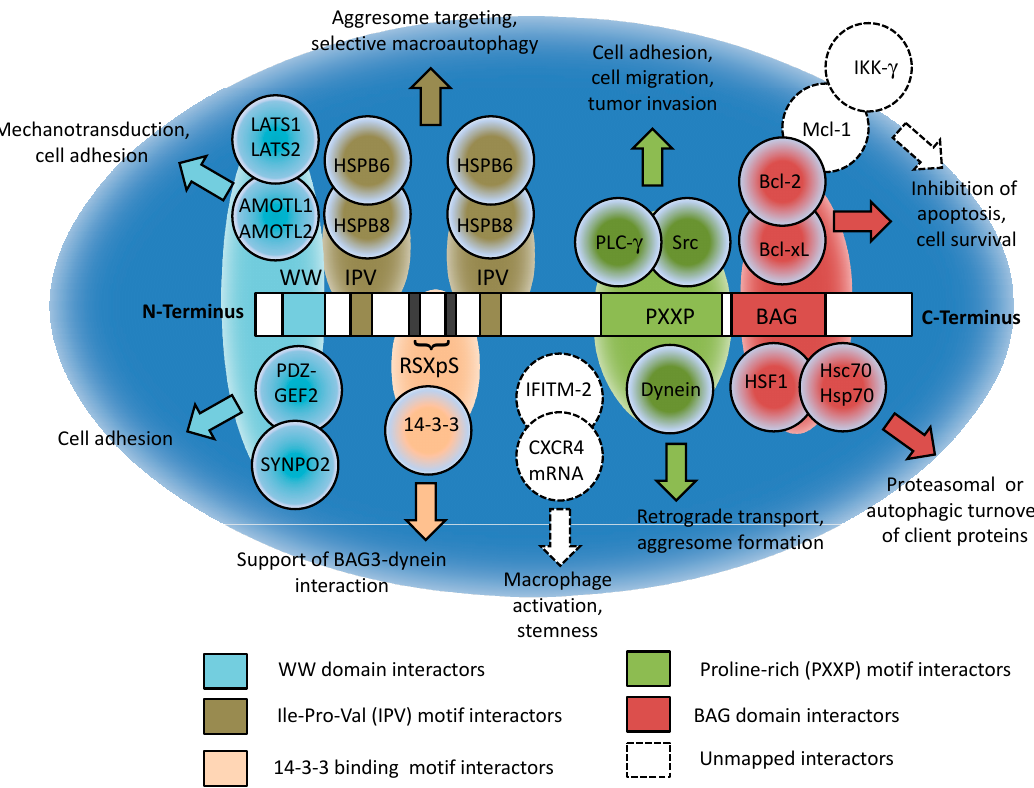
Figure 2. Domain structure of BAG3 and major interactors: BAG3 as a hub molecule regulating multiple pathways related to stress and therapy resistance. Key functional / interaction domains of BAG3, major BAG3 interactors, and associated pathways are depicted. The WW domain of BAG3 binds to proline-rich repeats of interactors, including LATS1 / 2, AMOTL1 / 2, the guanine nucleotide exchange factor 2 (PDZGEF2), and synaptopodin-2 (SYNPO2). The two conserved IPV motifs mediate complex formation of BAG3 to the small heat shock proteins HSPB8 and HSPB6. The PxxP motif interacts with the SH3 (Src homology 3) domains of phospholipase C gamma (PLC- γ ), Src and the motor protein dynein. BAG3 also possesses two phosphoserine-containing 14-3-3 binding motifs that interact with the 14-3-3 γ protein. The C-terminal BAG domain of BAG3 binds to several interactors, including the anti-apoptotic BCL-2 protein, the ATPase domain of the HSC / HSP70 chaperone, and the heat shock factor and BAG3 upstream transcriptional regulator HSF1. For further information, please refer to the main text and to [3]. WW: WW domain; IPV: Ile-Pro-Val motif; RSXpS: 14-3-3 binding motif; PXXP: proline-rich motif; BAG: BAG domain. Table 1. Aberrant expression of BAG3 in di ff erent cancer entities. Tumor Entity